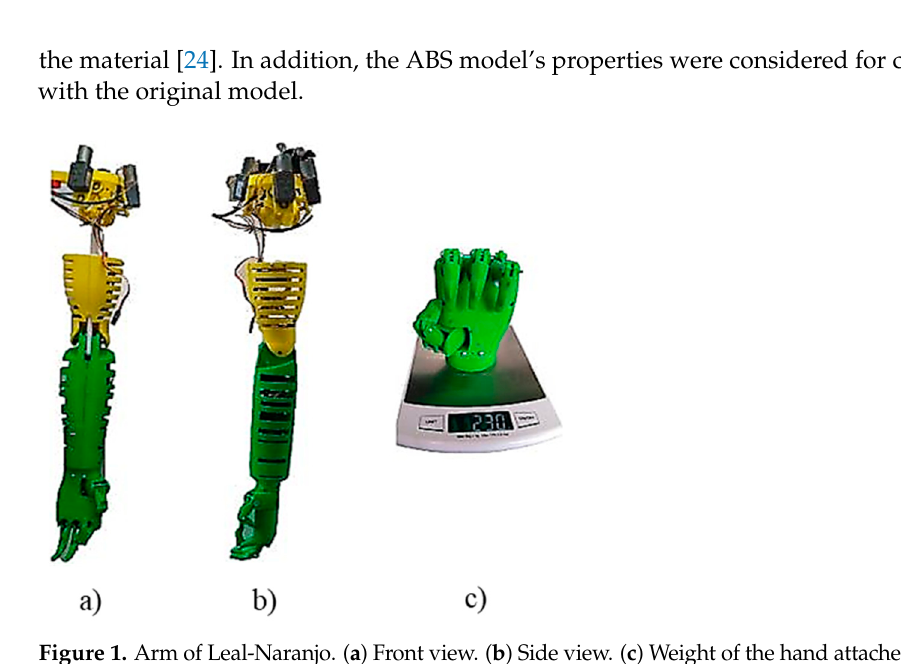
Table 1. Materials to manufacture.